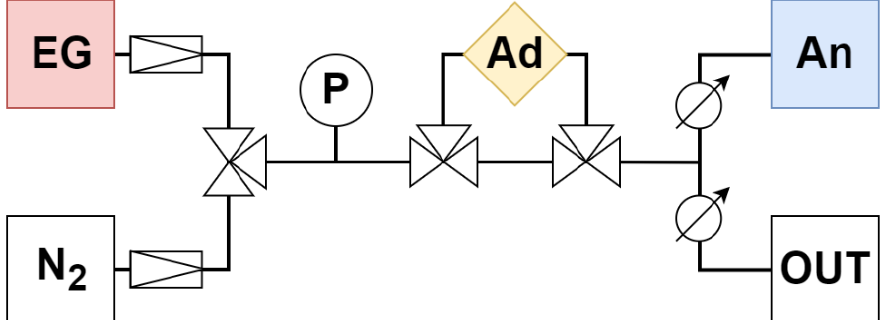
Figure 1. Diagram of adsorption apparatus with fittings. EG — emission gas, N 2 — nitrogen, P — pres- sure gauge, Ad — adsorption chamber, An — analyzer, OUT — overflow branch.